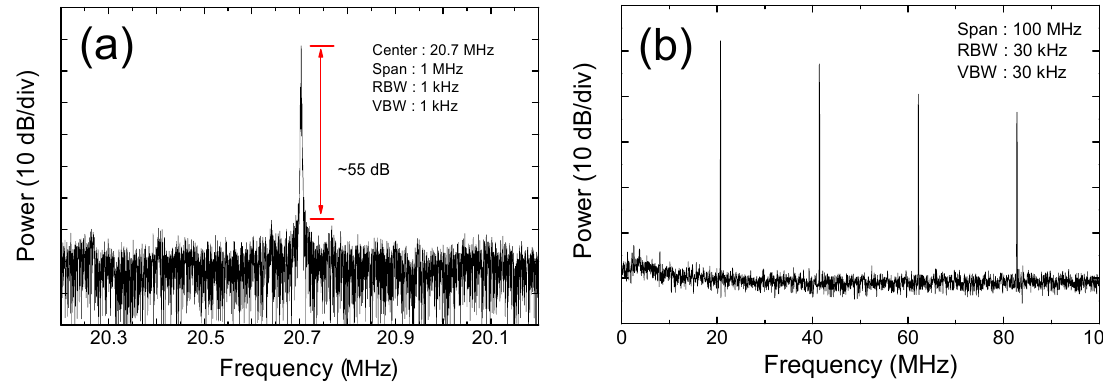
Figure 7. Measured electrical spectra of the dark pulses: ( a ) narrow span and ( b ) wide span.